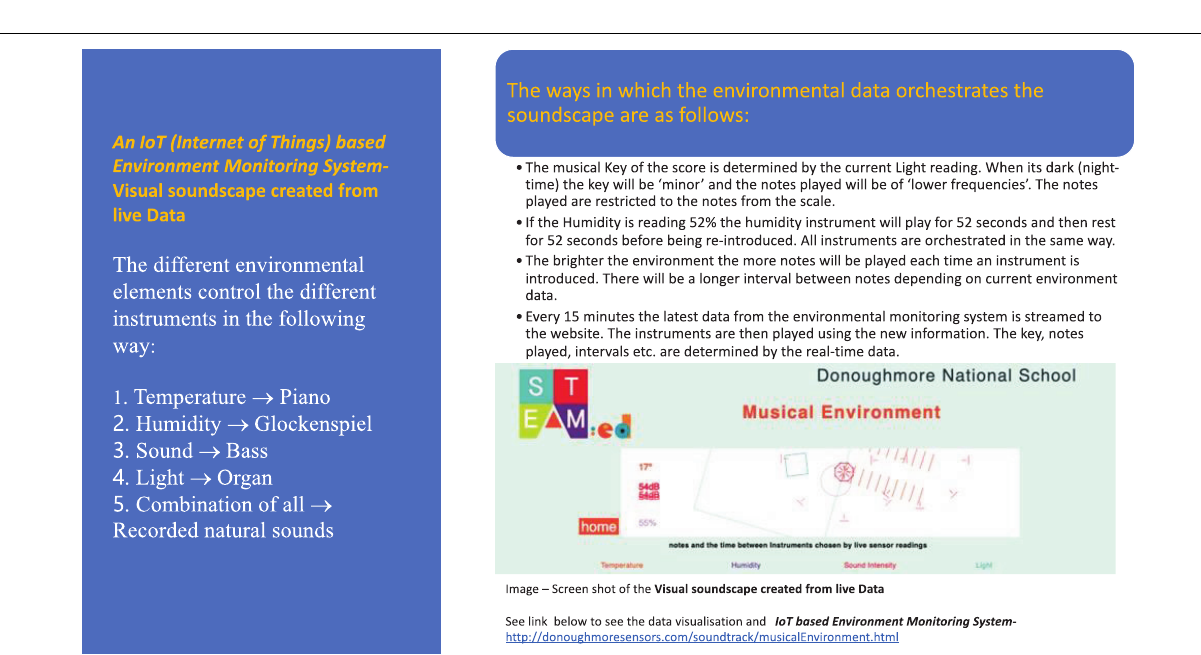
FIGURE 8 | Creating a musical score with